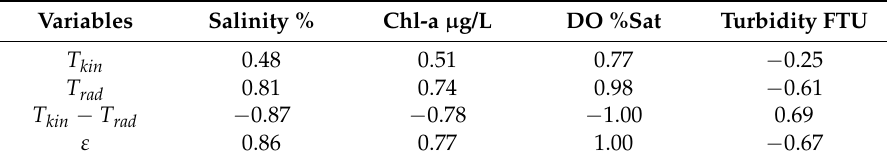
Table 4. Correlation coefficients between water quality parameters salinity (%), chlorophyll-a ( µ g/L), dissolved oxygen (DO, % saturation), turbidity (Formazin turbidity units, FTU), and in situ kinetic temperature, T kin ( ◦ C), IR thermographic radiometric temperature, T rad ( ◦ C), the difference of T kin and T rad , and the derived emissivity, ε , for the areas of